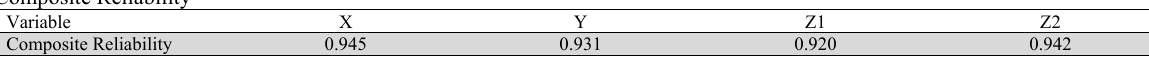
Composite Reliability